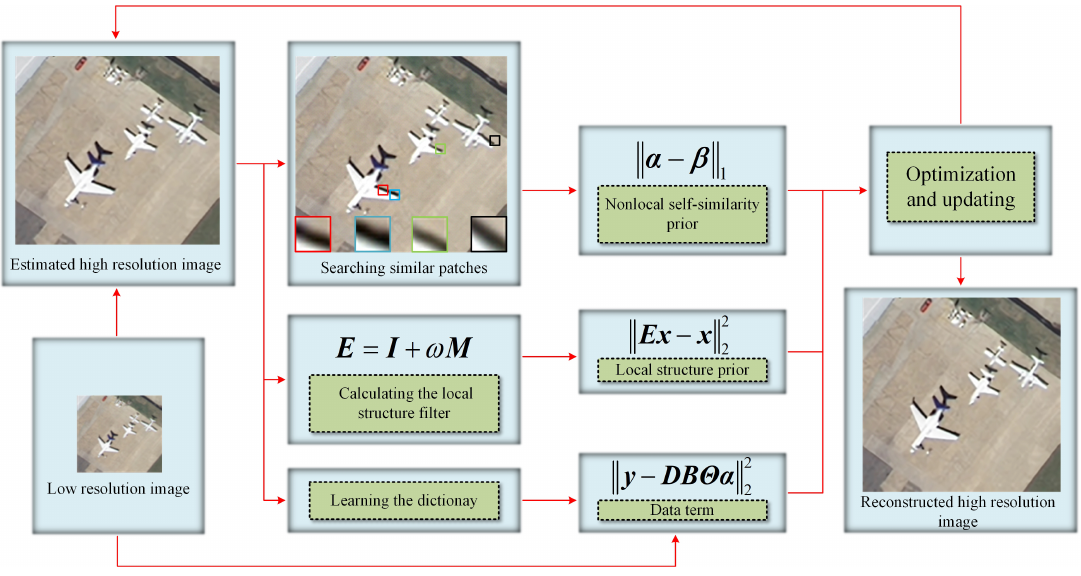
Figure 1. The proposed